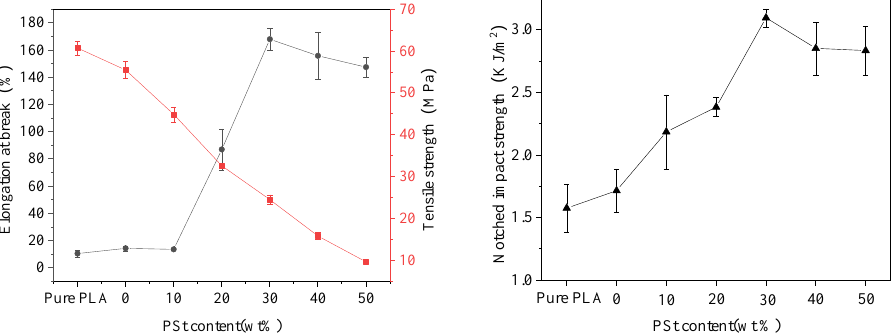
Figure 1. Mechanical properties of pure poly(lactic acid) (PLA) and PLA/premixed starch (PSt)/polyethylene glycol (PEG)/citric acid (CA) blends with different PSt contents.